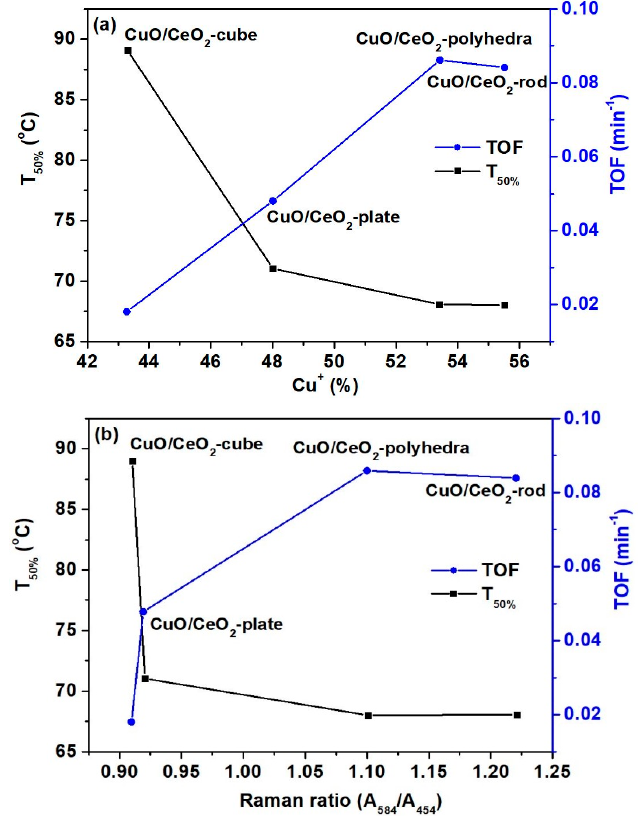
Figure 16. ( a ) TOF (60 ◦ C) / T 50% values versus Cu + content and ( b ) TOF (60 ◦ C) / T 50% values versus A 584 / A 454 ratios for CuO / CeO 2 catalysts with di ff erent morphologies. Adapted from Reference